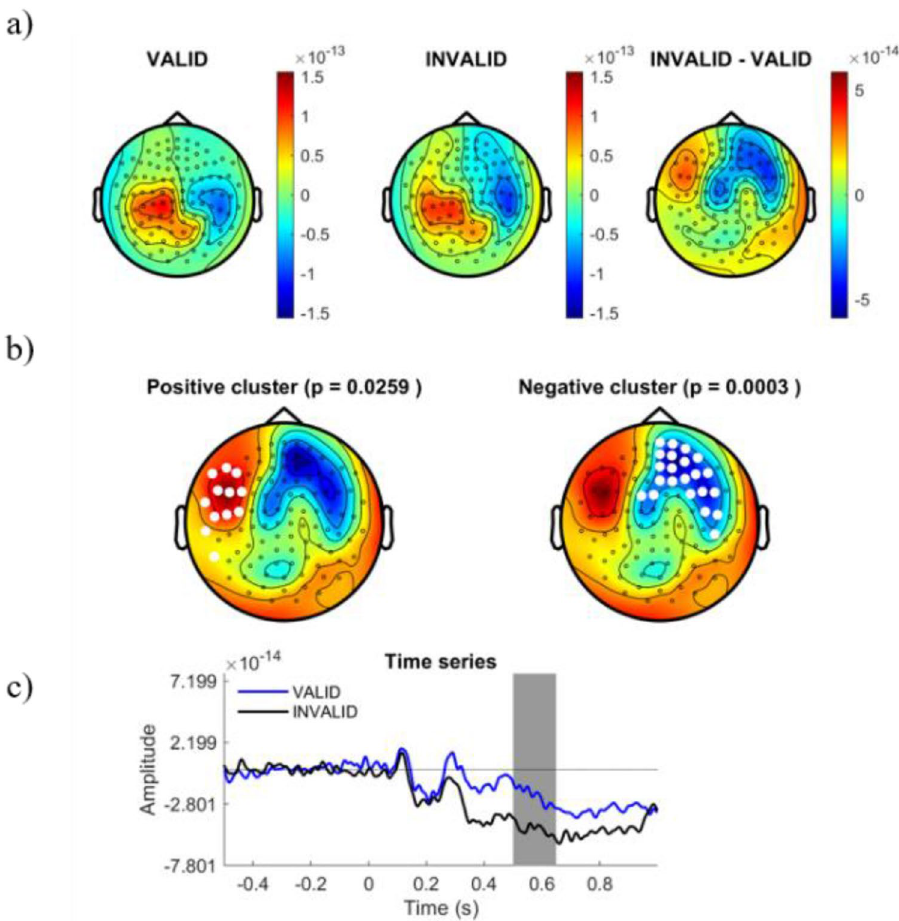
Figure 6. Represents the distribution of cortical activity in a time-slice from 500 to 650 ms. ( a ) Shows topographical maps of amplitudes for each condition (left and central map) and their arithmetic subtraction (right map). ( b ) Represents statistical differences (T values) between conditions. Left, positive cluster, and right, negative cluster. White dots represent sensors that showed significant differences during time-window. ( c ) Shows the whole time-series for both conditions (blue = VALID; black = INVALID). Grey mask represents time- slice of samples with significant